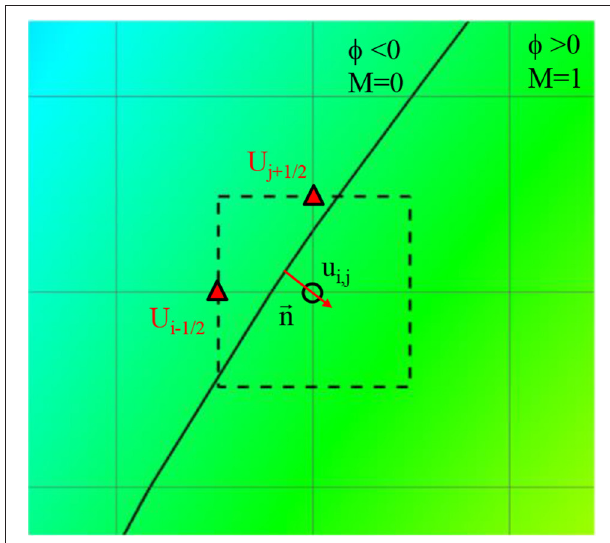
FIGURE 6 | Schematic describing of the calculation of velocity gradient near the wall. Solid line: Vessel wall boundary identified by the level-set function. Rectangle with dashed line: A computational cell adjacent to the wall. Triangle symbol: The cell face center where the boundary velocity is